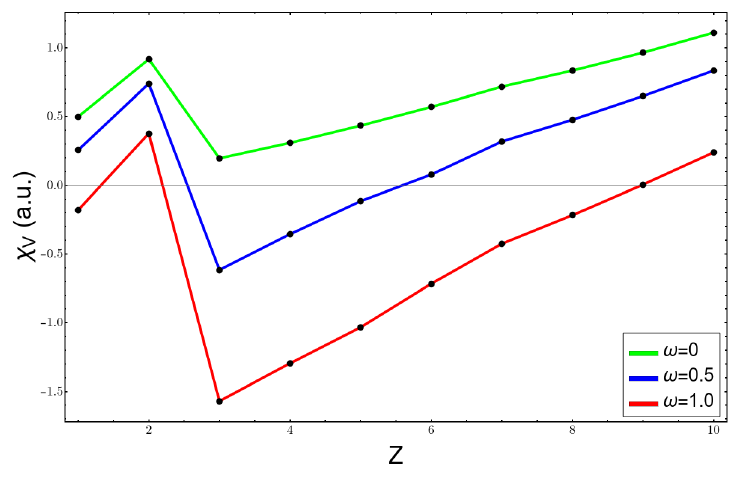
Figure 2. Electronegativity as the average electron binding energy at different confinement values for atoms from H to Ne.